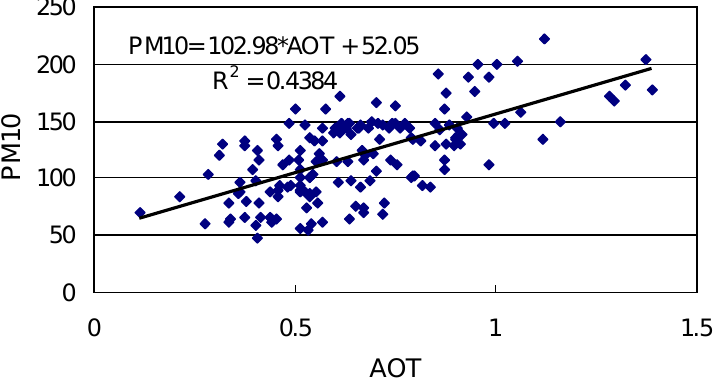
based on all 157 10